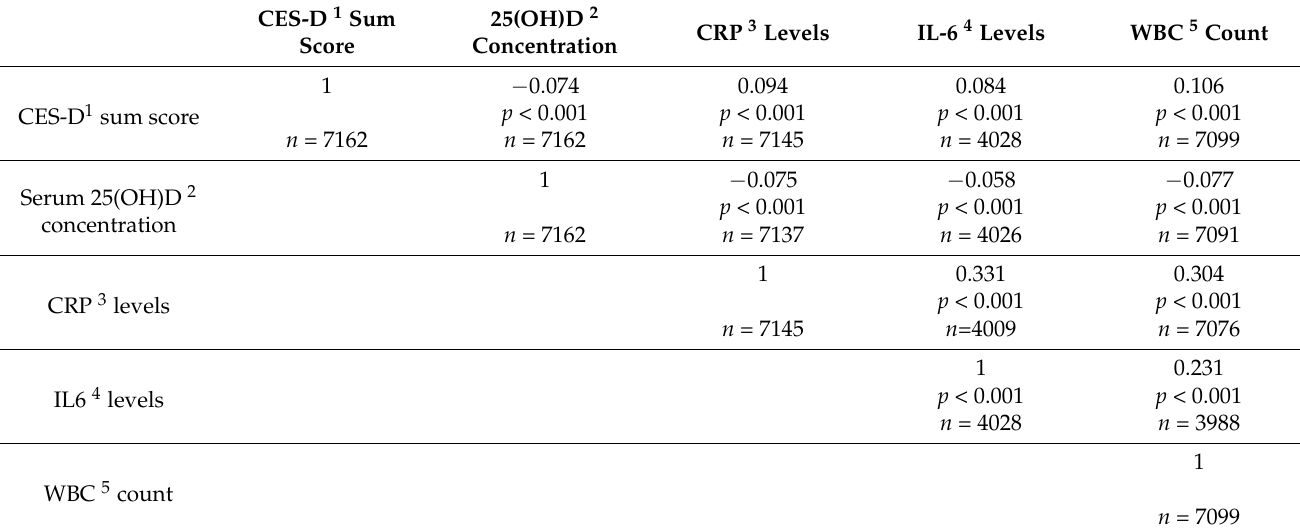
Table 2. Correlation coefficient matrix of serum 25(OH)D concentrations, CES-D sum scores and inflammatory